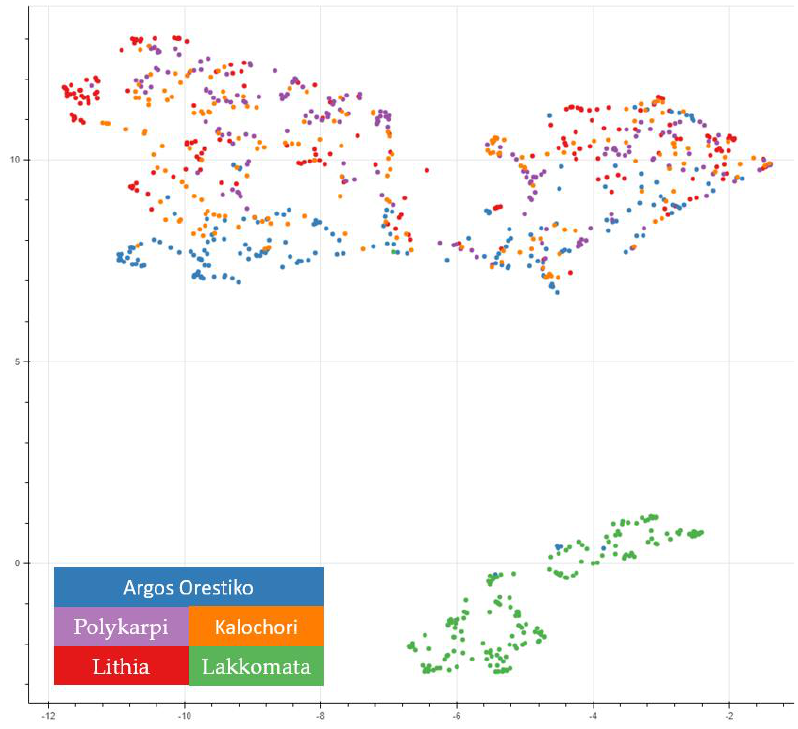
Figure 4. Topological data analysis of meteorological data from Kastoria.